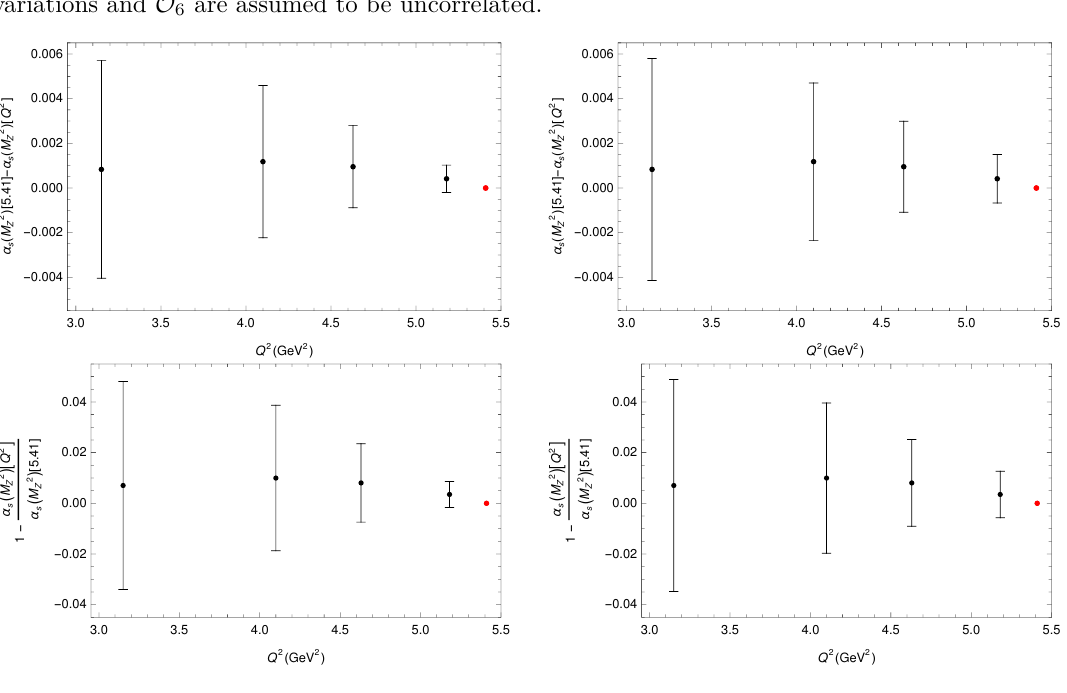
Figure 22 . The same as figure 20 but using the results of table